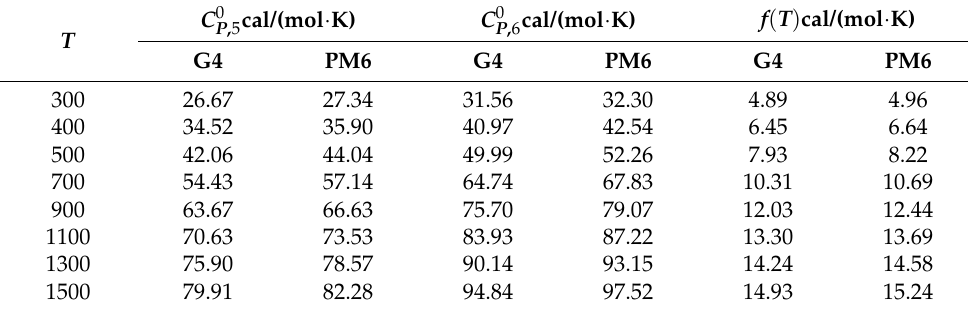
Table A4. Accuracy of Equation (5) for C 0 T ,